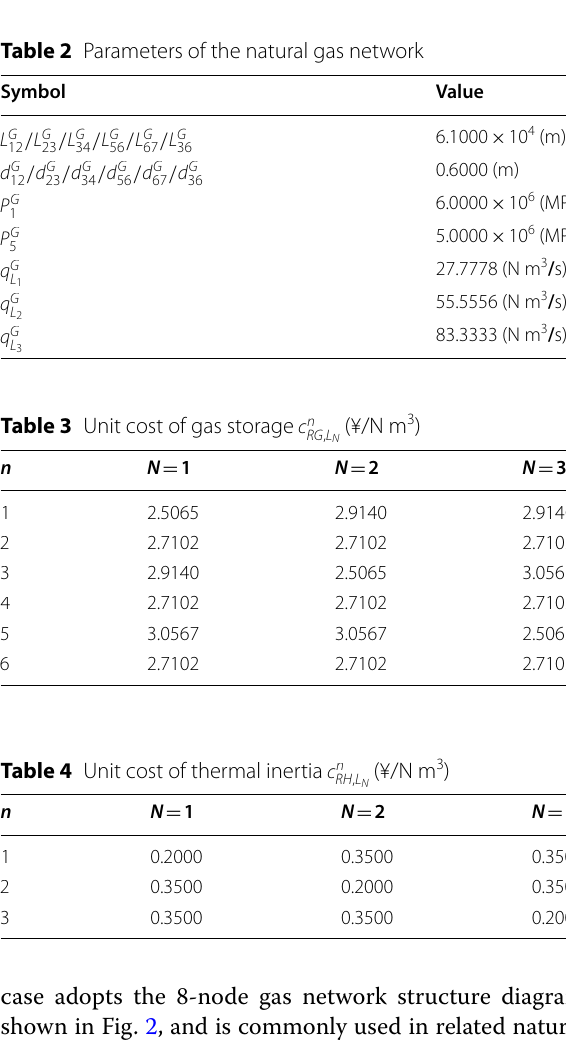
Table 2 Parameters of the natural gas network